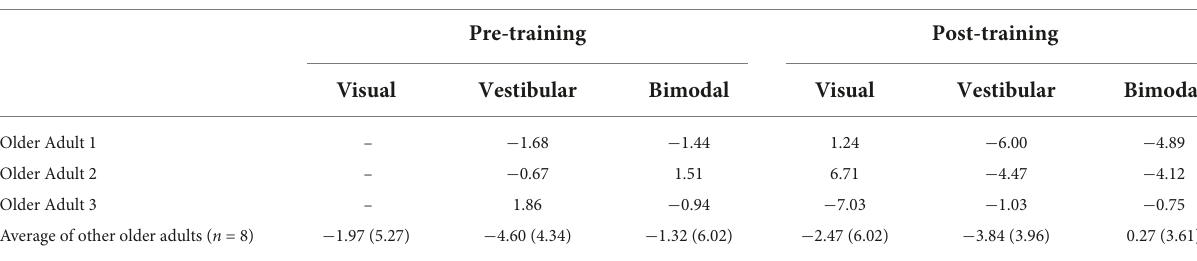
TABLE 2B Biases for the three older adults who could not perform the visual-only heading task pre-training, as well as the group average and standard deviations for the rest of the older adult group.